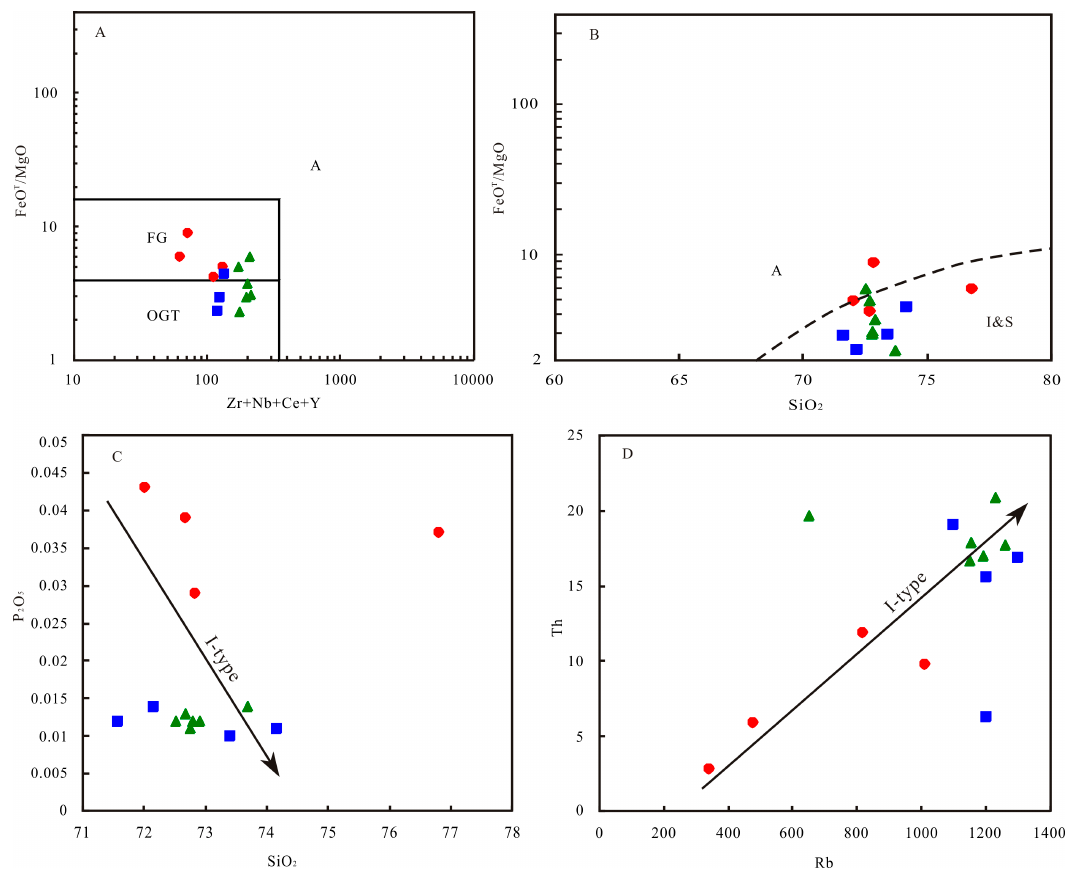
Figure 11. ( A ) Zr + Nb + Ce + Y versus FeO T /MgO diagram (Whalen et al. [81] ); ( B ) SiO 2 versus FeO T /MgO diagram (Eby et al. [82] ); ( C ) SiO 2 versus P 2 O 5 diagram; ( D ) Rb versus Th diagram. Same symbols as Figure 8. FG—fractionated I-type granite; OGT—unfractionated I, S and M type granite; A—A-type granite; I—I-type granite; S—S-type granite.